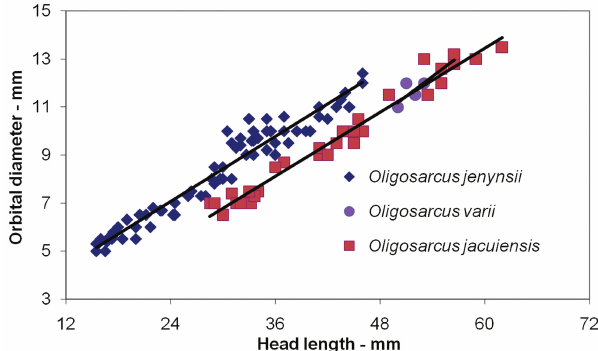
Fig. 2. Horizontal orbital diameter as a function of head length for Oligosarcus varii . Oligosarcus jenynsii and O. jacuiensis introduced for comparisons.